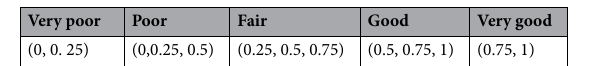
Table 3. Fuzzy sets to assess the